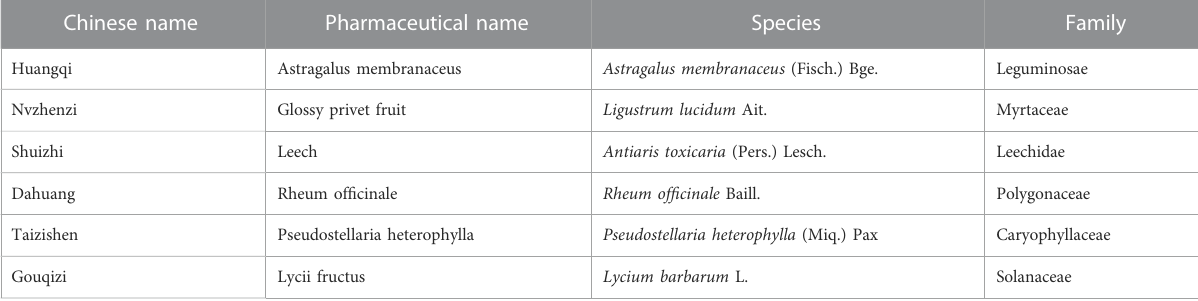
TABLE 1 Complete name and species of ingredients of